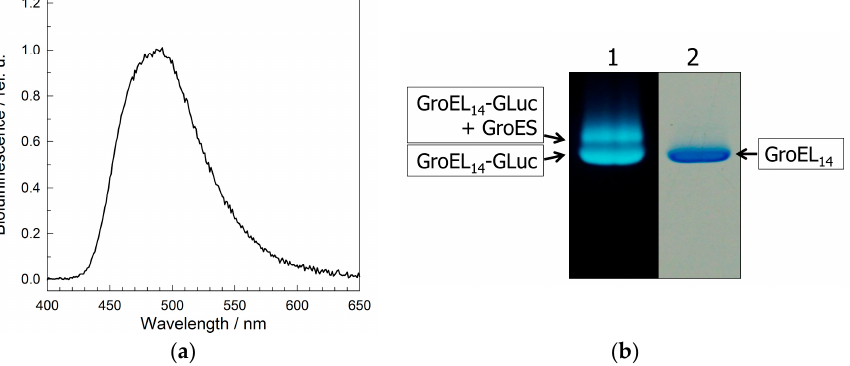
Figure 6. Physicochemical properties of GroEL 14 with incorporated Gaussia princeps luciferase (Gro- EL 14 -GLuc): ( a ) the bioluminescence spectrum of cells after coexpression of pAC28 groEL-Luc and pET11c groES/EL; ( b ) nondenaturing PAGE of the cell lysate in the presence of Mg-ADP (Lane 1) and purified GroEL 14 (Lane 2). Protein band visualization by bioluminescence (Lane 1) and Coomassie staining (Lane